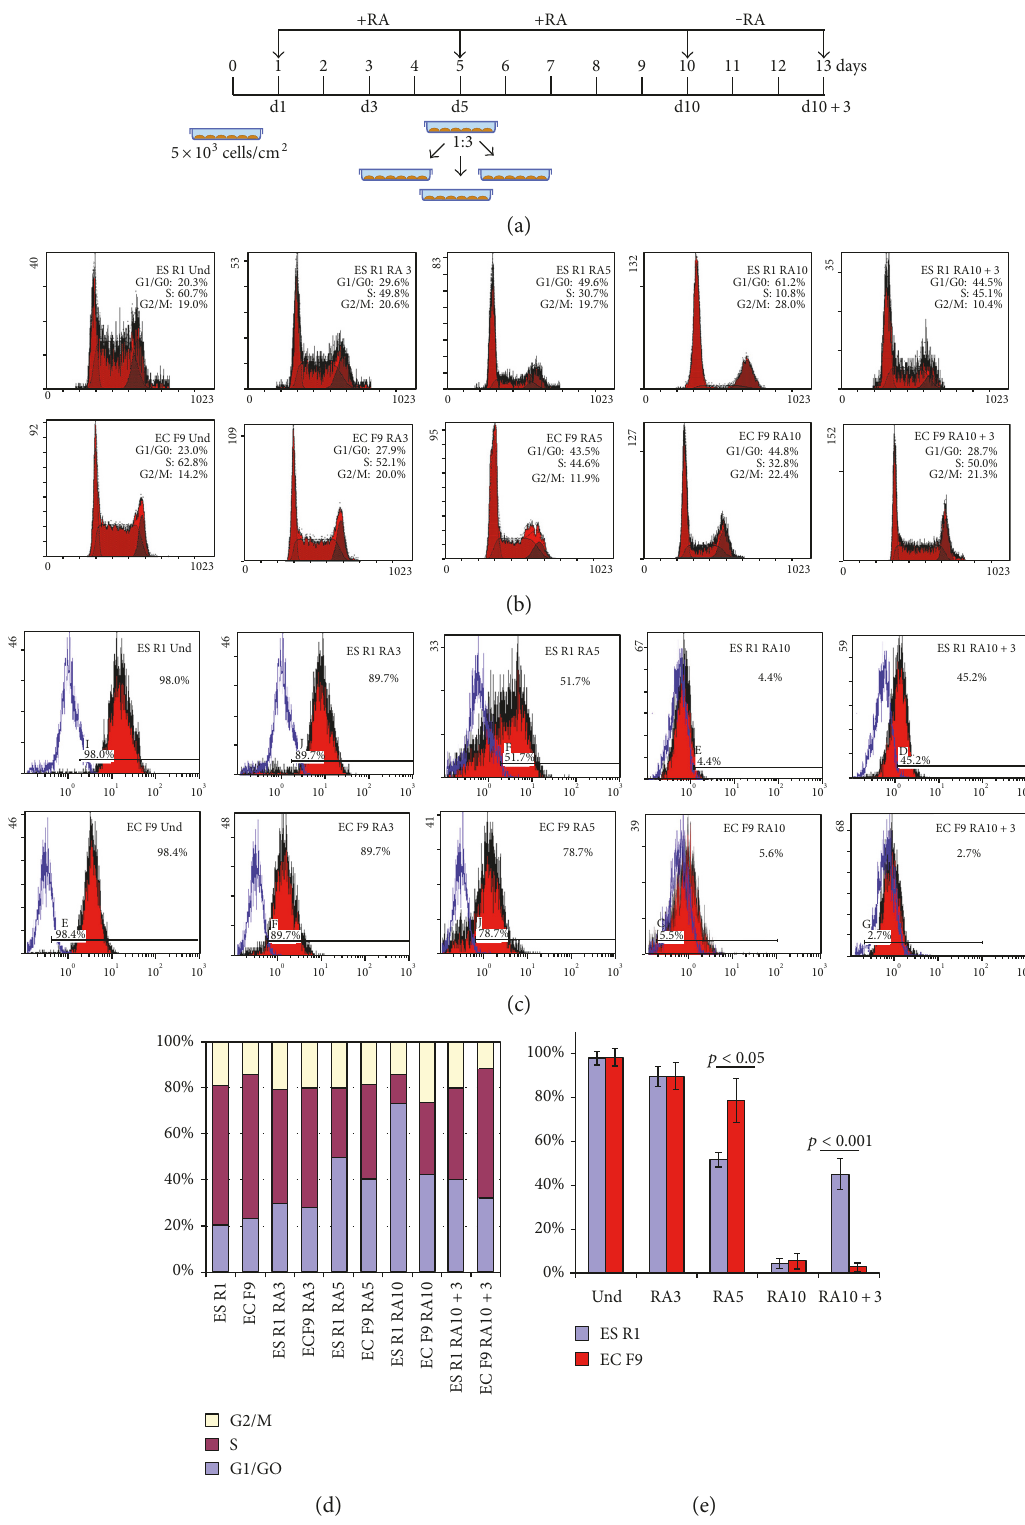
Figure 1: Proliferative activity and di ff erentiation dynamics of ES R1 and EC F9 cells after 10 days of RA stimulation and 3 days after RA withdrawal. (a) Experimental design of RA-induced di ff erentiation of ES R1 and EC F9 cells. (b and d) Flow cytometric analysis of the distributions of the cell cycle stages in the populations of RA-stimulated ES R1 and EC F9 cells. (c and e) Flow cytometric analysis of the number of Oct4-expressing cells in the populations of RA-stimulated ES R1 and EC F9 cells. The data are represented as the mean ± s.e.,